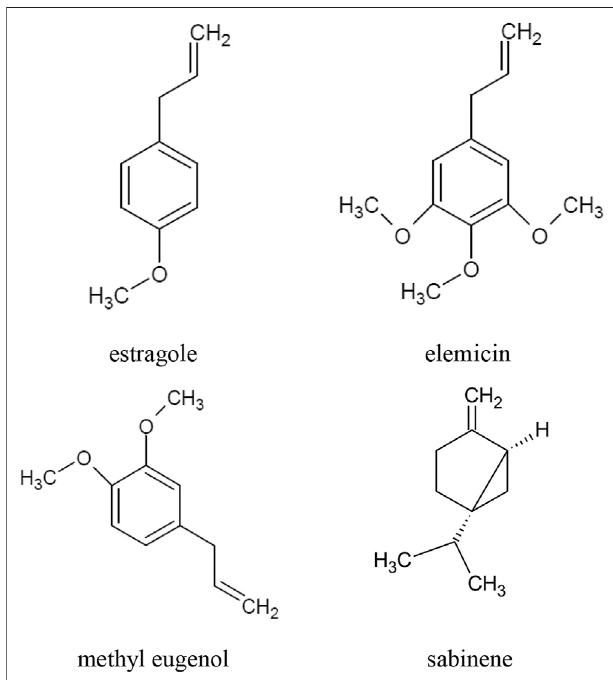
FIGURE 1 | Chemical structure of volatile compounds characteristic of the essential oil of the A. dracunculus herb.